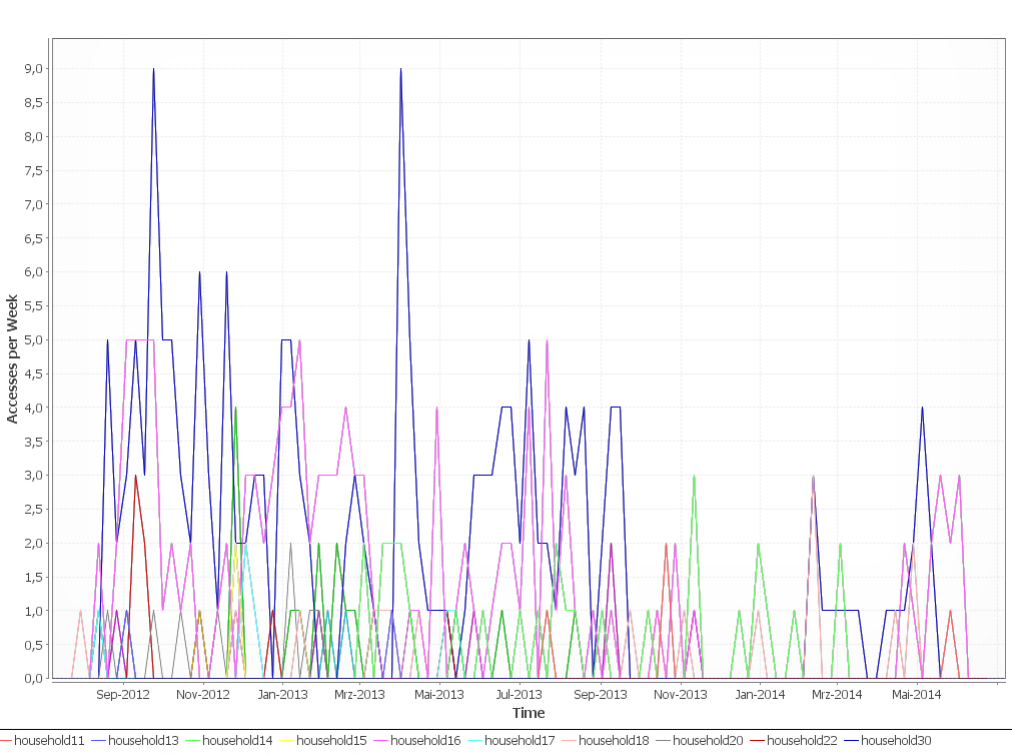
Figure 11. Frequency and temporal changes in the usage of the weather